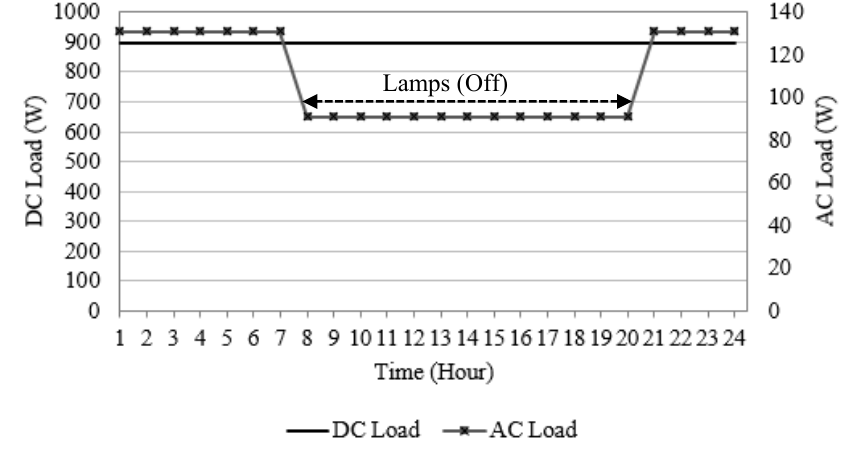
Figure 3. Hourly load profile for the LTE macro-BS.